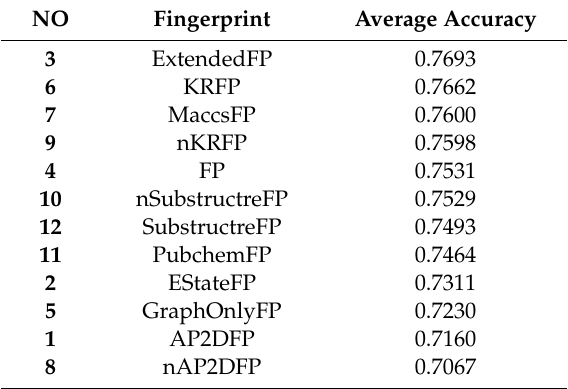
Table 2. Sorted Average Accuracies of the Top 5 Classifiers with Respect of Di ff erent